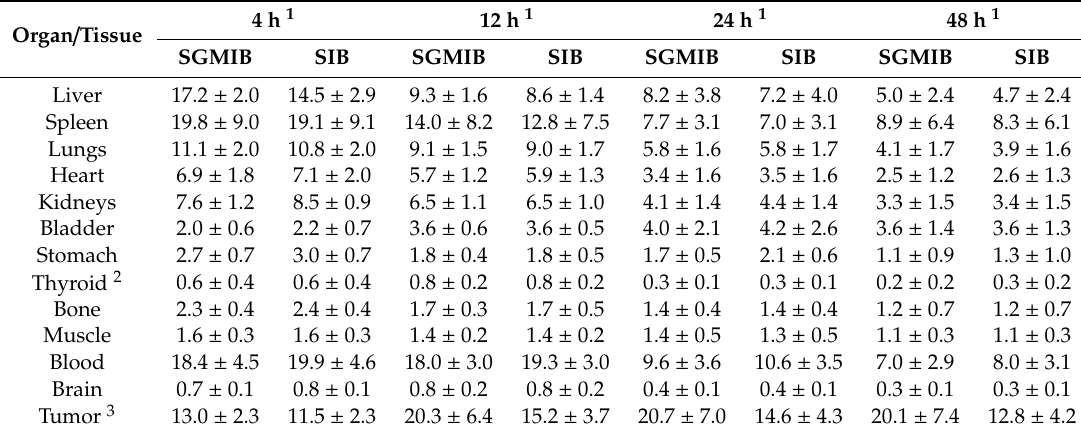
Table 1. Paired-label biodistribution data for the [ 125 I]SGMIB-trastuzumab (SGMIB) and [ 131 I]SIB-trastuzumab (SIB) in NSG mice bearing subcutaneous BT474M1 xenografts, and expressed as % injected dose per gram tissue (% ID / g). Organ /